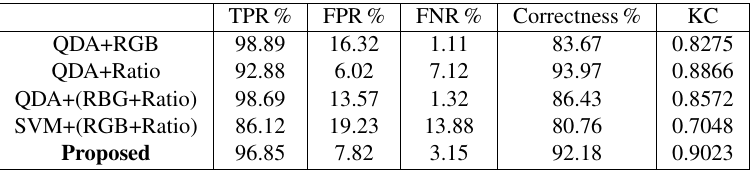
Table 2. The shadow detection result for different classifications on AssenDelft